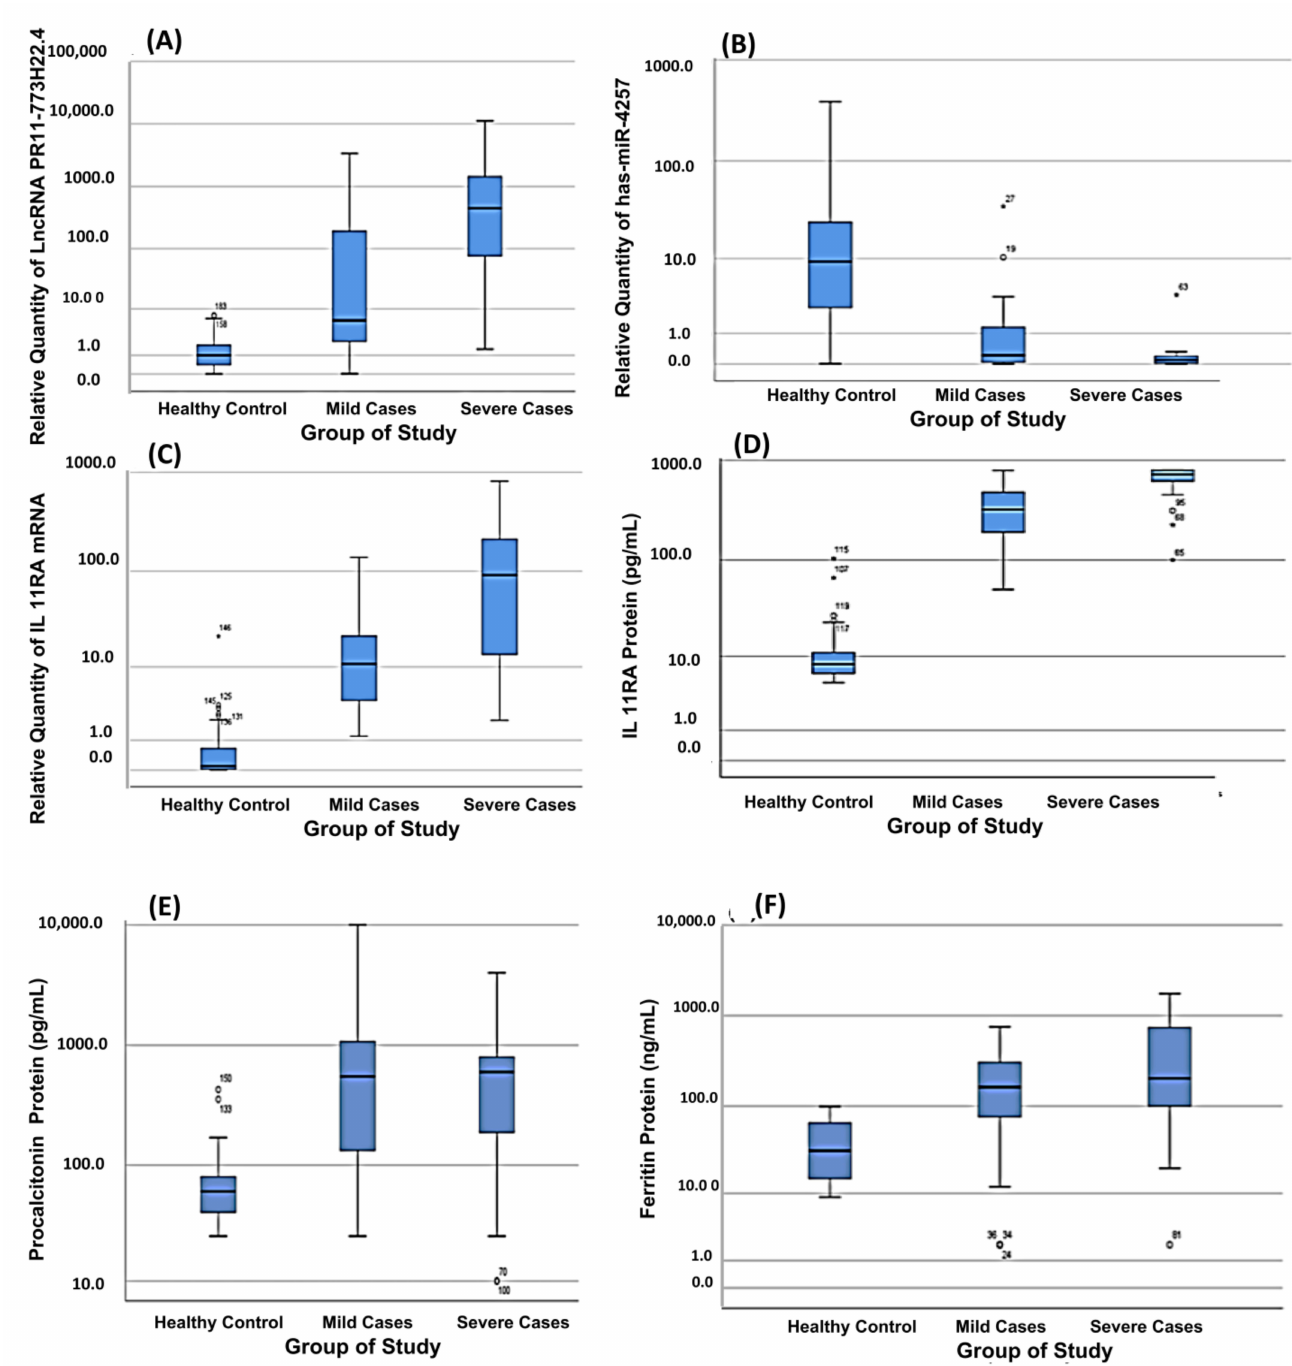
Figure 1. The differential box plot analysis of the investigated biomarkers, measured by qRT-PCR or ELISA, among the study groups. ( A ) LncRNA RP11-773H22.4, ( B ) HSA-MIR-4257, ( C ) IL11RA mRNA, ( D ) IL11RA protein, ( E ) pro-calcitonine and ( F ) ferritin. The median is represented as a line inside the box, and the 1st and 3rd quartiles are represented by the top and bottom lines of the box, respectively. Dots represent